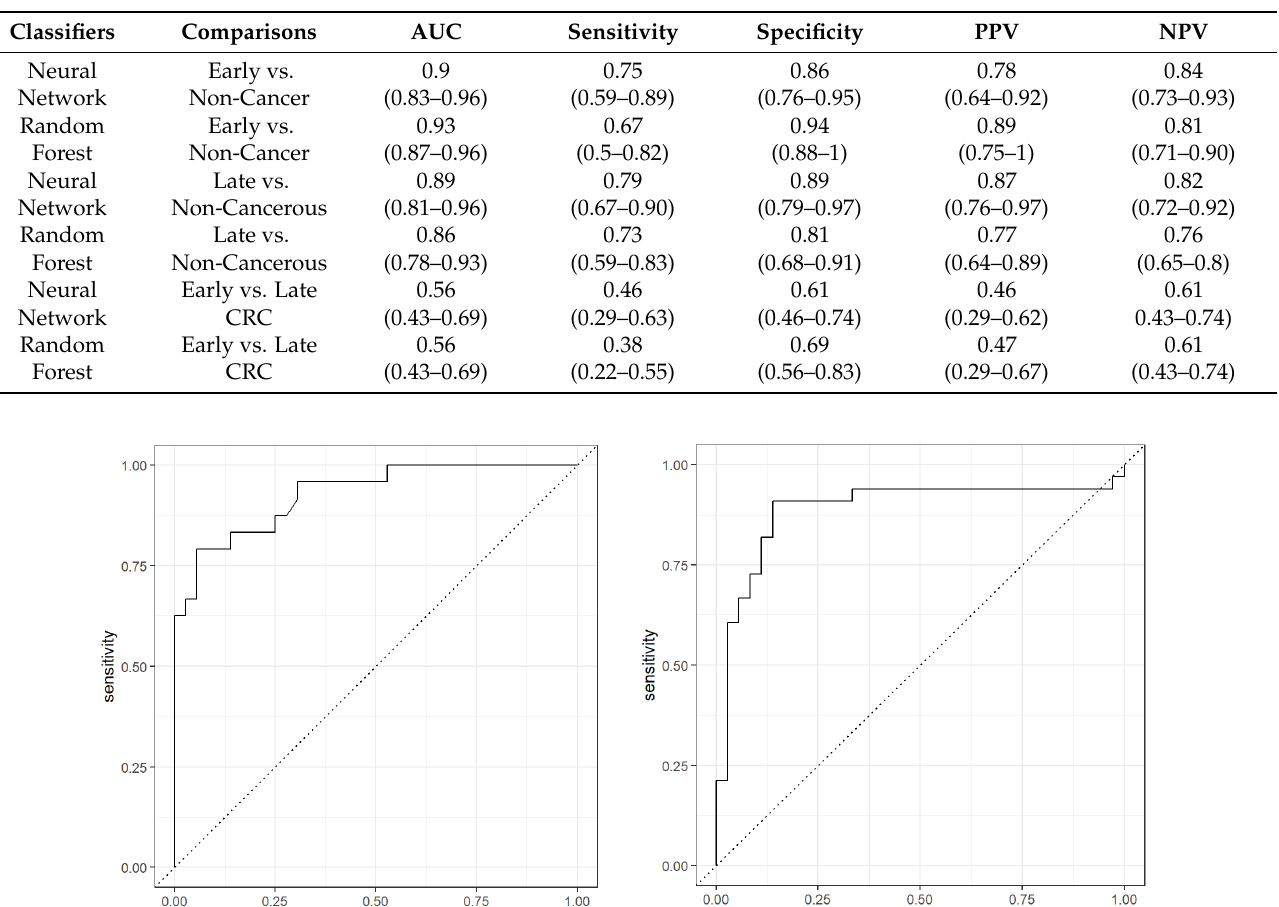
Table 7. Statistical Results for CRC stage comparisons with 95% confidence intervals in brackets using GC-TOF-MS.